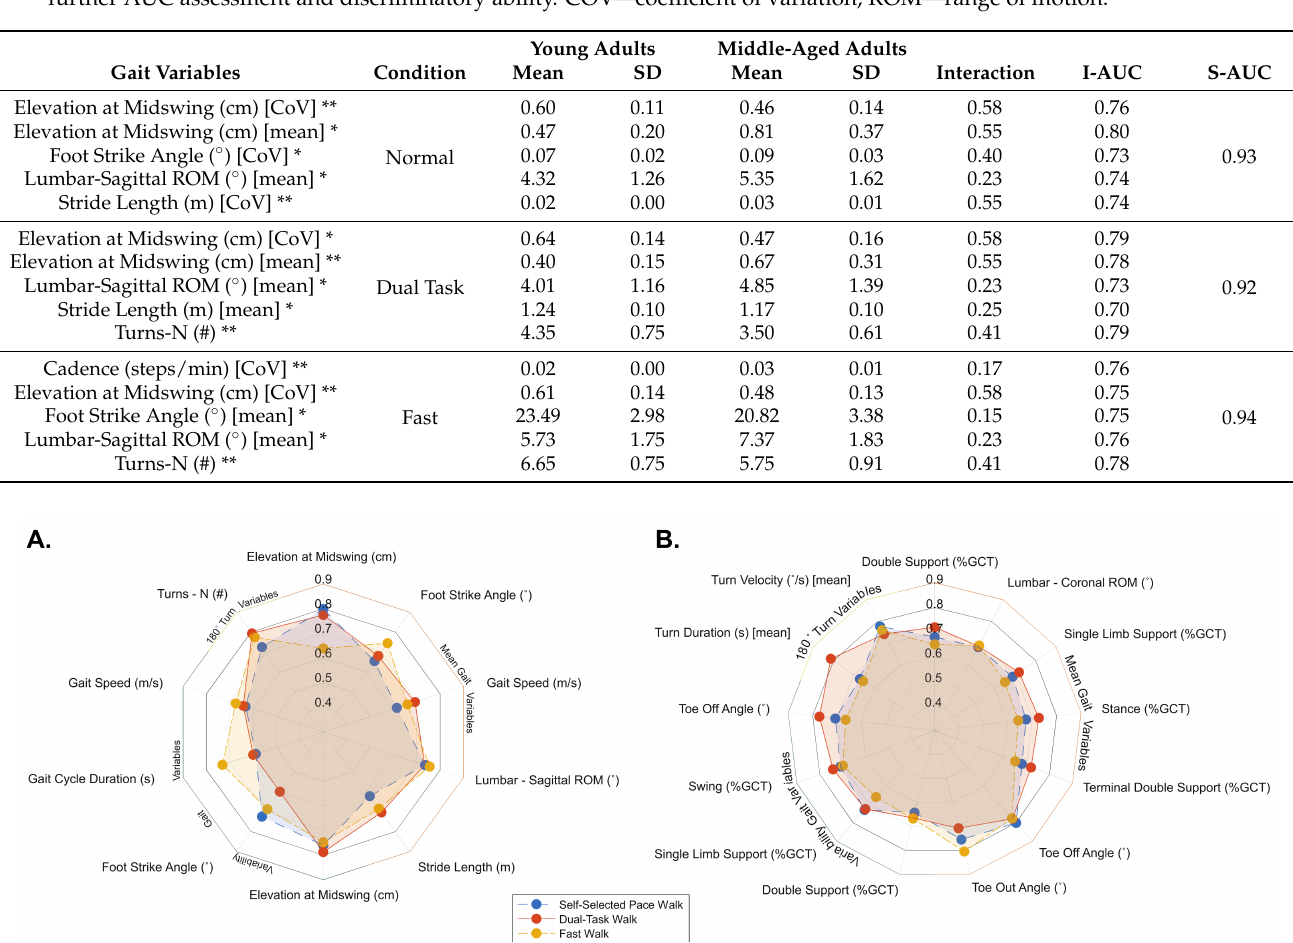
Table 2. Top five AUC producing gait variables for each walking condition, their associated means ± SD, RMANOVA group by condition interaction p -value, independent AUC (I-AUC) value, and stepwise regression AUC (S-AUC) value. Variable(s) with a single (*) were included in the stepwise regression, those with a (**) were maintained in the regression for further AUC assessment and discriminatory ability. COV—coefficient of variation, ROM—range of motion.